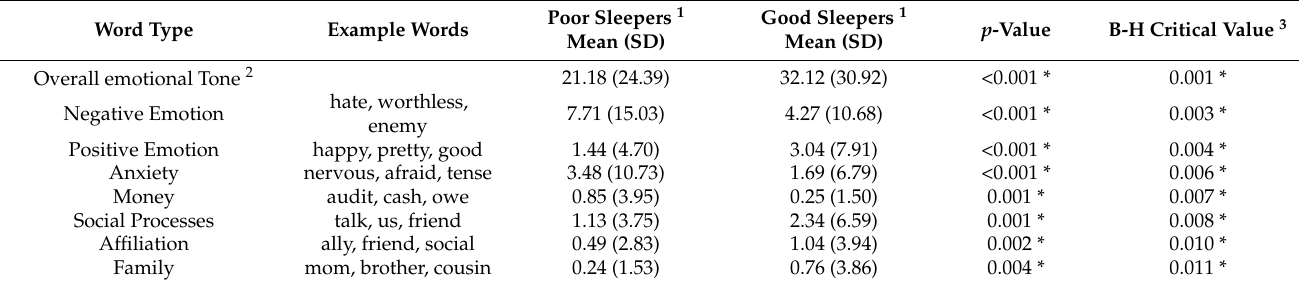
Table 2. Differences between poor sleepers ( n = 601) and good sleepers ( n = 501) for LIWC categories based on the language used by participants to describe their experiences during the